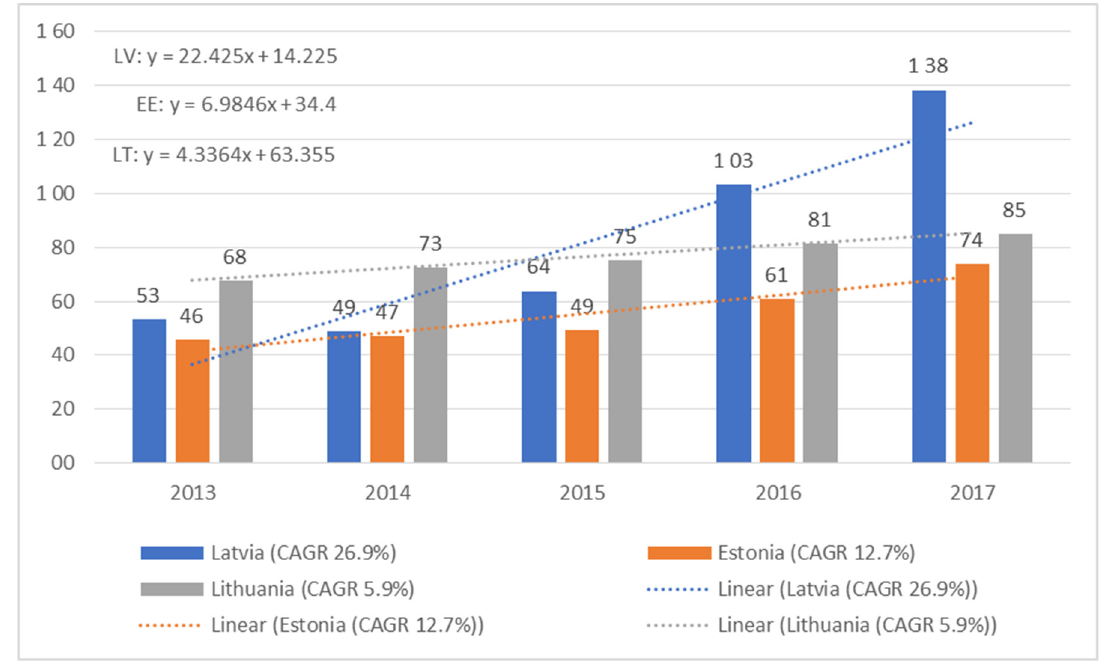
Figure 3. The average usage frequency for one company.